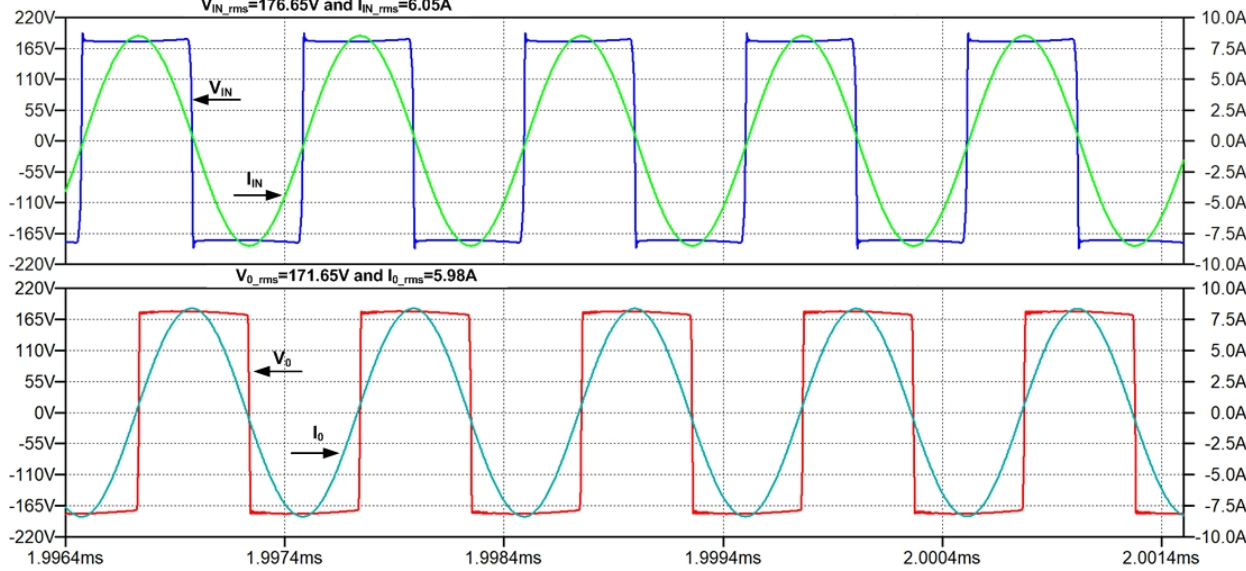
Figure 19. Voltage V RL =95.67VDC(red) and current I RL =1.91ADC (blue) waveforms at the load.